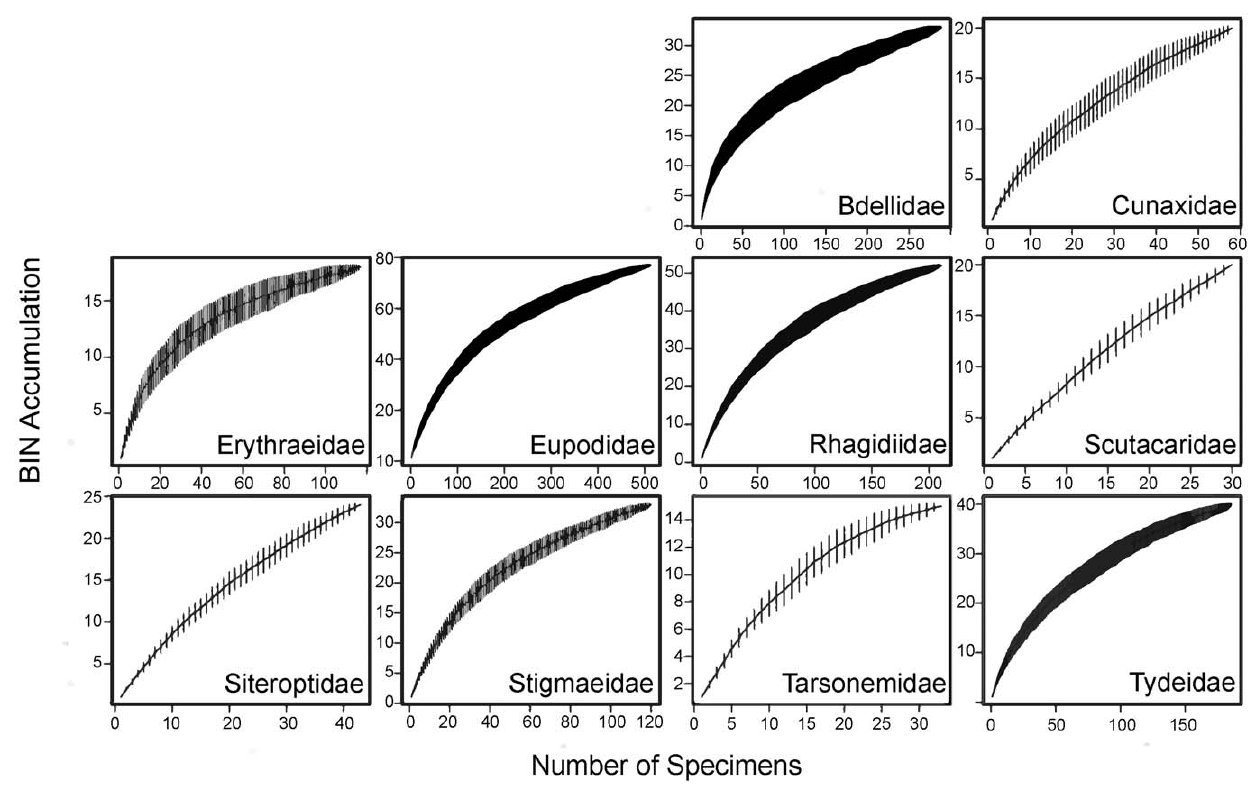
Figure 7. BIN accumulation curves for 10 families of Trombidiformes.